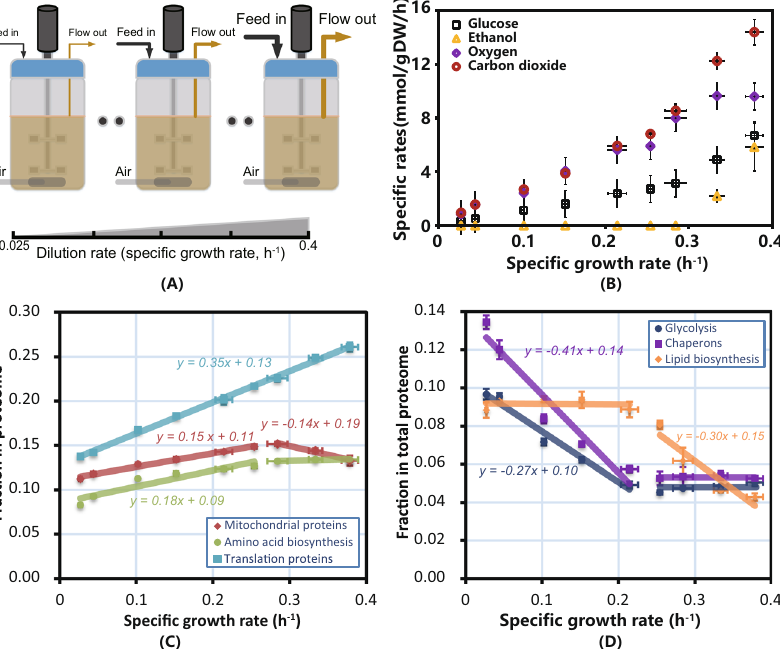
Fig. 1 Experimental design, chemostat series experimental results and linear relationship between different protein categories and speci fi c growth rates. A The experimental design was based on glucose-limited chemostat cultures operated within a range of dilution rates (equal to speci fi c growth rates, nine different values) from 0.025 to ~0.4 h − 1 . The line width of the arrow represents the fl ow of feed and ef fl uent. B Key exchange fl uxes measured at different dilution rates. All error bars were obtained based on biological triplicates and data are presented as mean ± SD. C Changes in the fraction of the proteome allocated to translation (ribosome protein), mitochondrial, and amino acid biosynthesis across different speci fi c growth rates. Protein allocation in these regions is correlated with speci fi c growth rates. Error bars derived from n = 3 biologically independent samples and data are presented as mean ± SD. D Changes in the fraction of the proteome allocated to chaperones, glycolysis, and lipid biosynthesis across different speci fi c growth rates. Error bars derived from n = 3 biologically independent samples and data are presented as mean ± SD. Protein allocation in these categories is inversely correlated with the speci fi c growth rate. Source data are provided as a Source Data fi